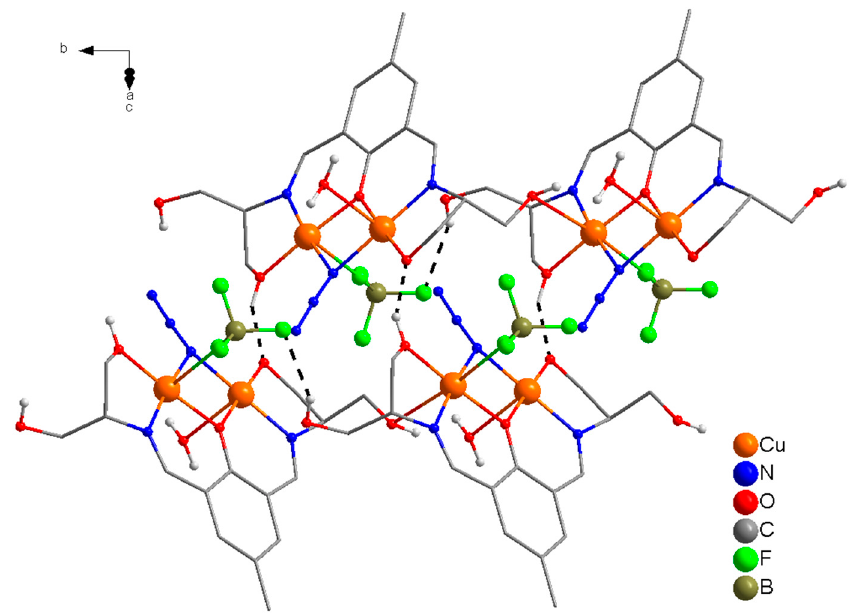
Figure 8. Perspective view of a portion of 3D supramolecular structure of 4 .